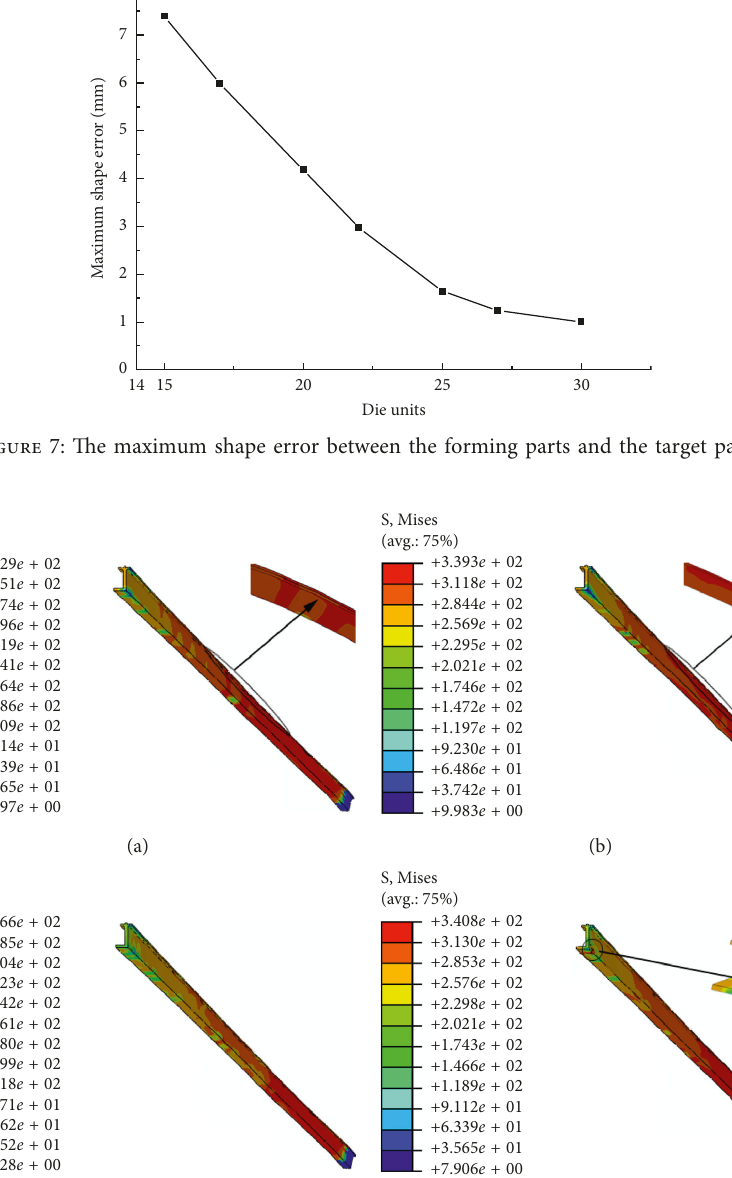
15, (cid:31) (cid:31)